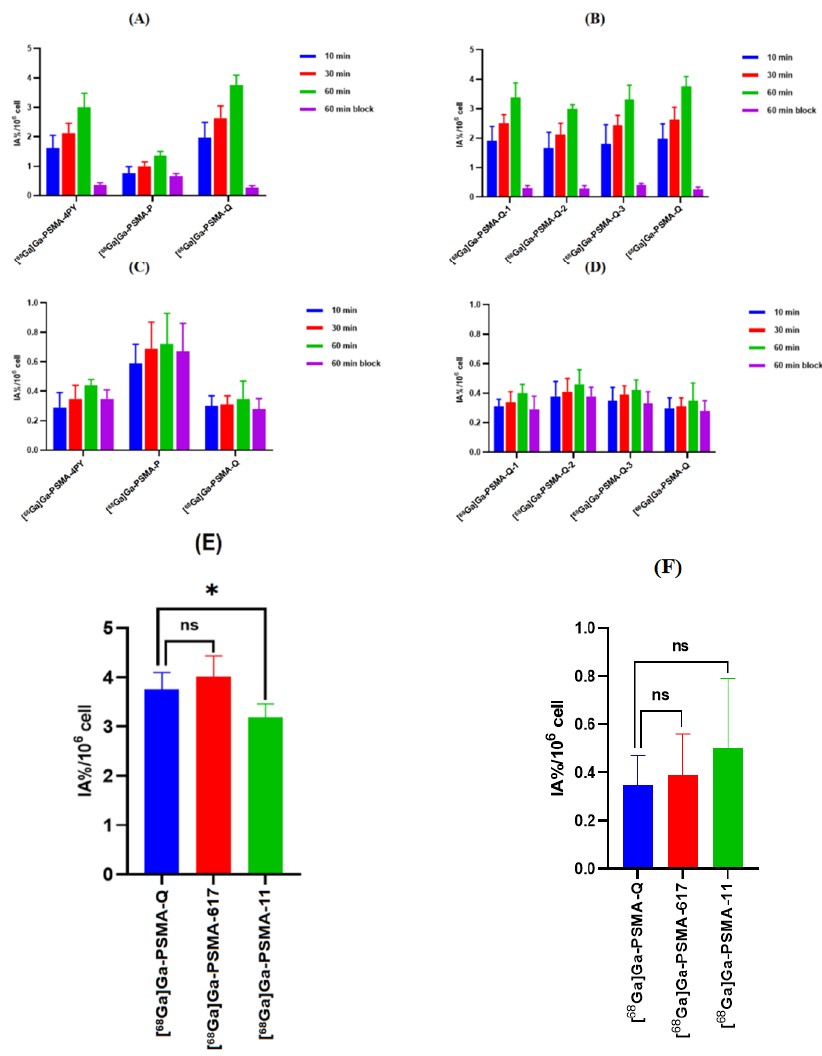
Figure 4. ( A , B ) Cell uptake of novel radiotracers in 22Rv1 cells. ( C , D ) Cell uptake of novel radio- tracers in PC-3 cells. ( E ) Comparison of cell uptake of [ 68 Ga]Ga-PSMA-Q, [ 68 Ga]Ga-PSMA-11, and [ 68 Ga]Ga-PSMA-617 in 22Rv1 cells at 60 min. ( F ) Comparison of cell uptake of [ 68 Ga]Ga-PSMA-Q, [ 68 Ga]Ga-PSMA-11, and [ 68 Ga]Ga-PSMA-617 in PC-3 cells at 60 min p.i. (* p < 0.05).